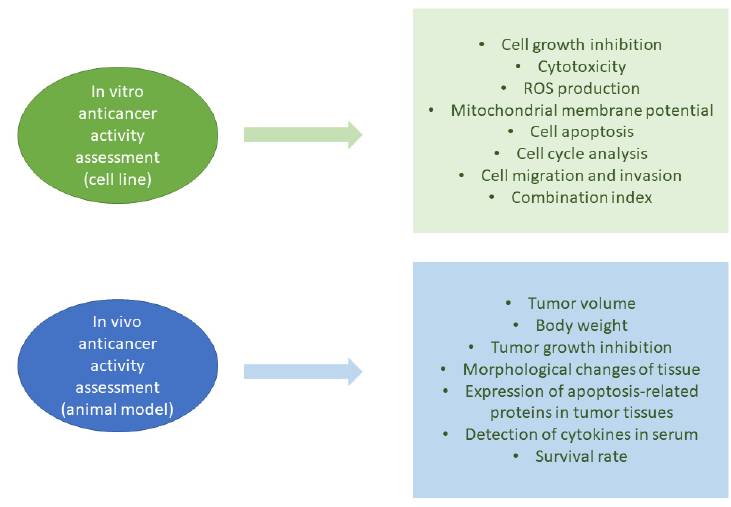
Figure 2. Markers for anticancer activity assessment. ROS: reactive oxygen species.